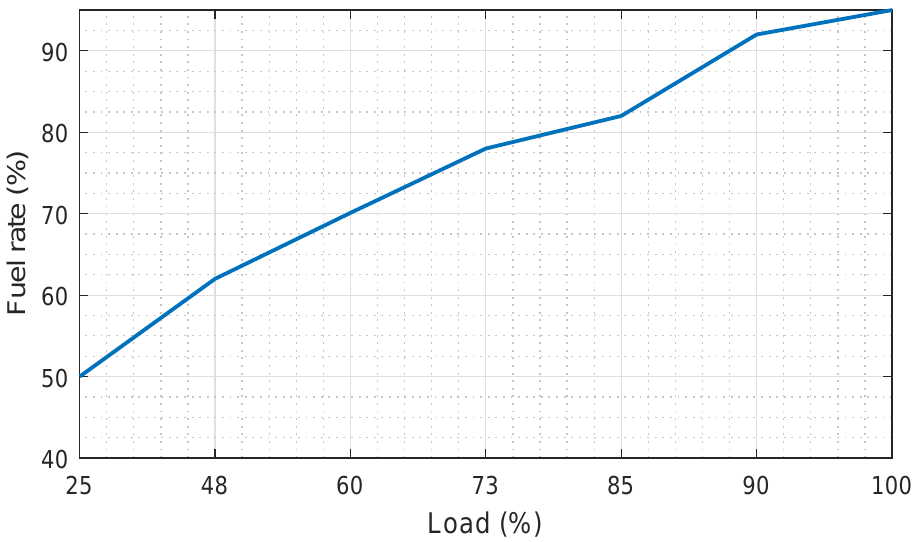
Figure 6. Fuel consumption as a function of load